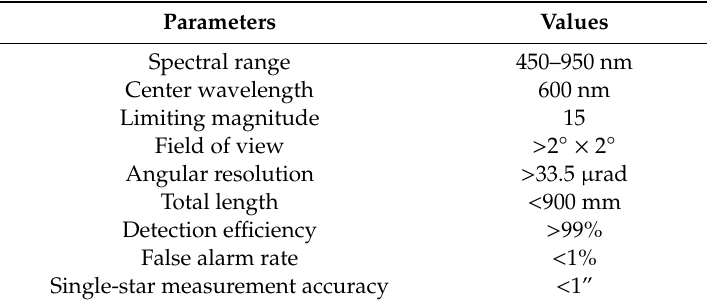
Table 1. Star sensor functional